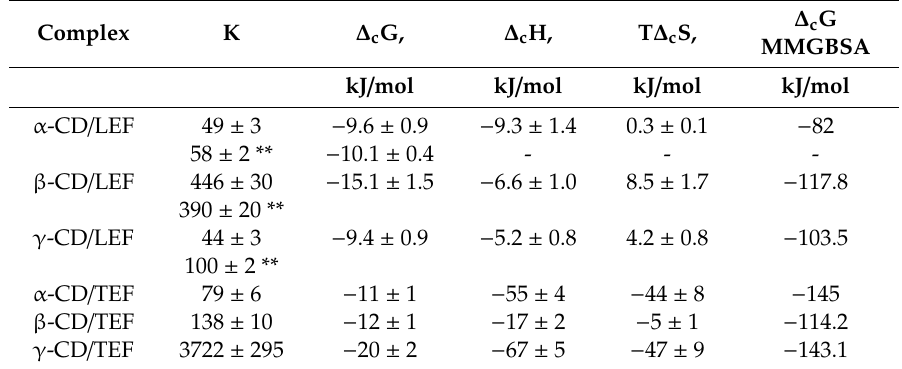
Table 2. Thermodynamic parameters of complex formation of CDs with LEF and TEF * and free energy estimation by molecular mechanical / generalized Born surface area